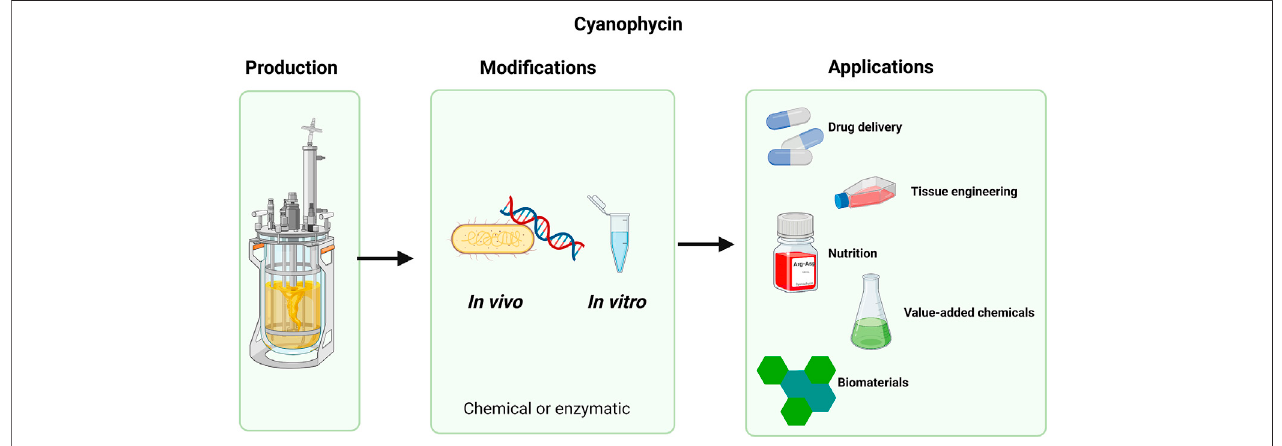
FIGURE 2 | Flow chart presenting the cyanophycin life cycle. From microbial production, through chemical or enzymatic modi fi cations to valuable